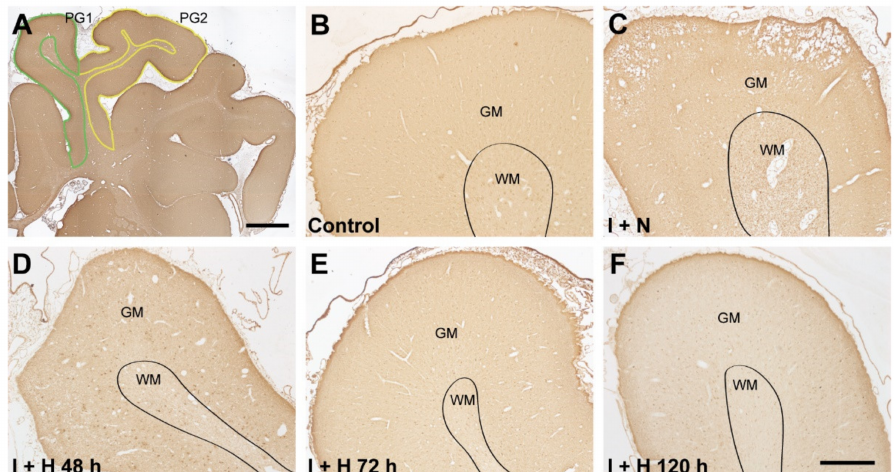
Figure 1. Photomicrographs of glutamate decarboxylase (GAD + ) interneurons showing the cortices of the first (( A ); green outline [PG1]) and second (( A ); yellow outline [PG2]) parasagittal gyri, and the changes of tissue integrity in the PG1 in sham control ( B ), cerebral ischemia + normothermia (I + N; ( C )), cerebral ischemia + hypothermia 48 h (I + H 48 h; ( D )), cerebral ischemia + hypothermia 72 h (I + H 72 h; ( E )), and cerebral ischemia + hypothermia 120 h (I + H 120 h; ( F )) groups at 7 days recovery. Scale bar: 500 µ m.